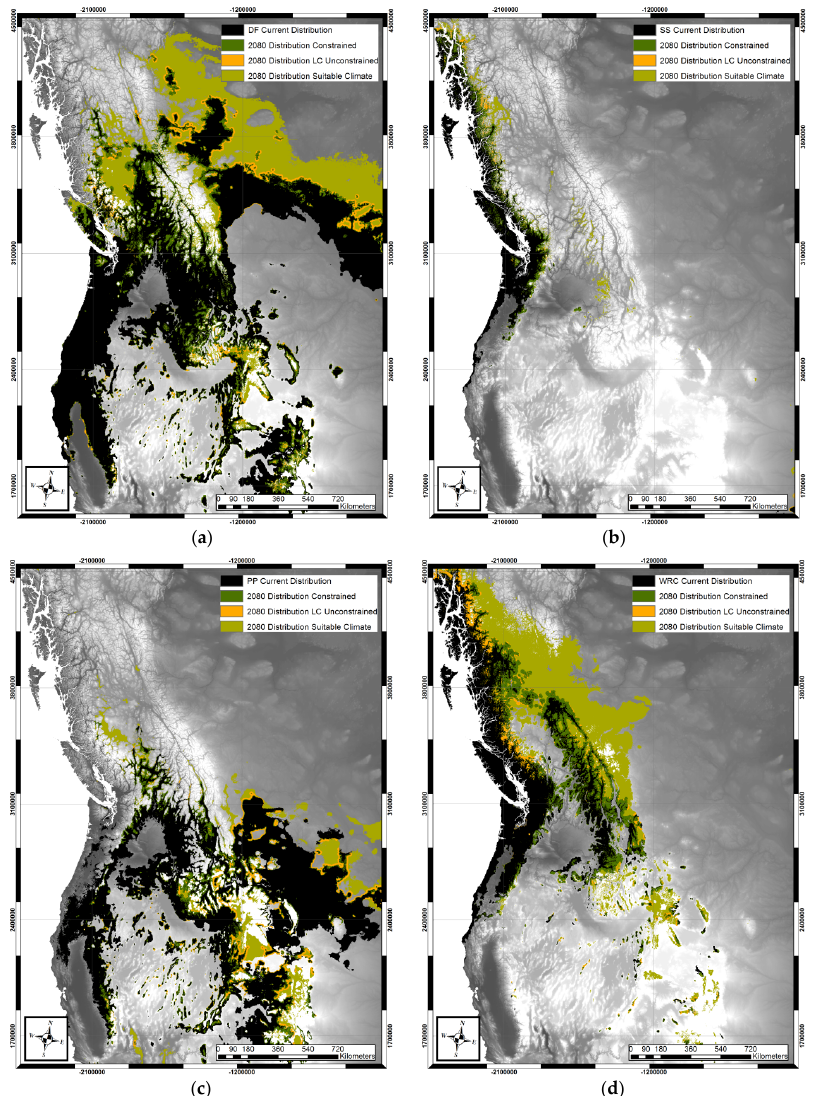
Figure 5. Predicted distributions of Douglas-fir (DF), Sitka spruce (SS), ponderosa pine (PP) and western redcedar (WWR). For each of the species, the maps depict: ( a ) current distributions; ( b ) 2080 distributions with climate and landscape barriers imposed; ( c ) distributions with a maximum 200-m/y limit constraint (LC) and favorable climatic conditions; and ( d ) limits imposed by climate alone.